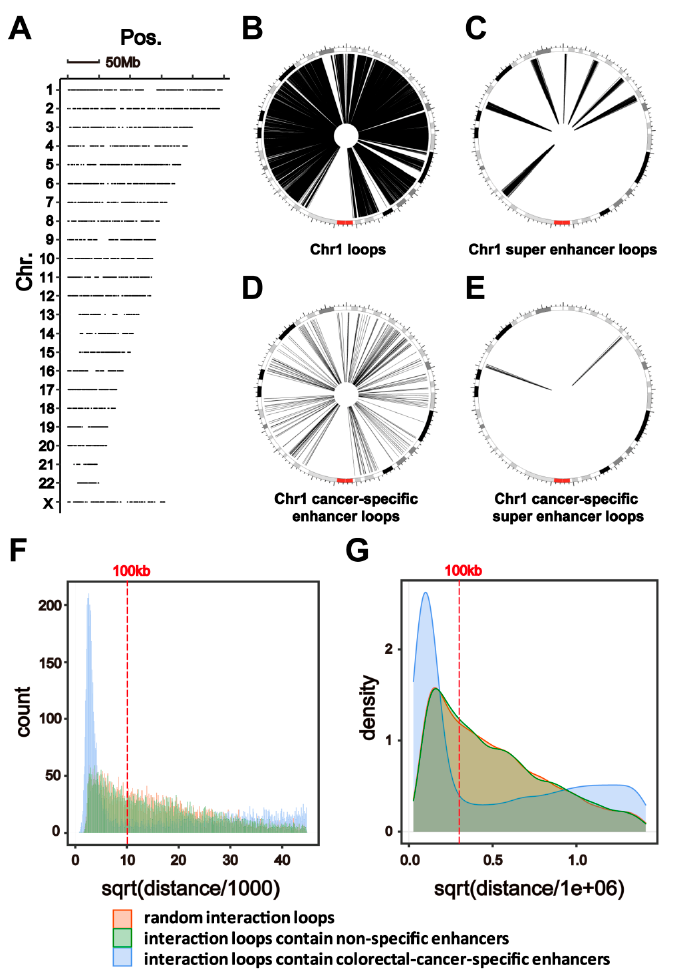
Figure 3. HiChIP identified chromatin interactions containing colorectal-cancer-specific enhancers. ( A ) Distributions of colorectal-cancer-specific enhancers of the human genome (hg19). ( B,C ) Circos plot showing interactions in Chr1, as indi- cated by curves extending from enhancers and super enhancers in colorectal cancer cells. Each curve in the Circos plot indicates one interaction loop that contains enhancers or super enhancers. ( D,E ) Circos plot showing interactions in Chr1, as indicated by curves extending from colorectal-cancer-specific enhancers and super enhancers in colorectal cancer cells. Each curve in the Circos plot indicates one interaction loop that contains colorectal-cancer-specific enhancers or super enhancers. ( F,G ) An analysis of the length distribution of random interaction loops from HiChIP data (red), the interaction loops that contain colorectal-cancer-non-specific enhancers (green) and colorectal-cancer-specific enhancers (blue, p < 2.2 × 10 − 16 compared with the other two